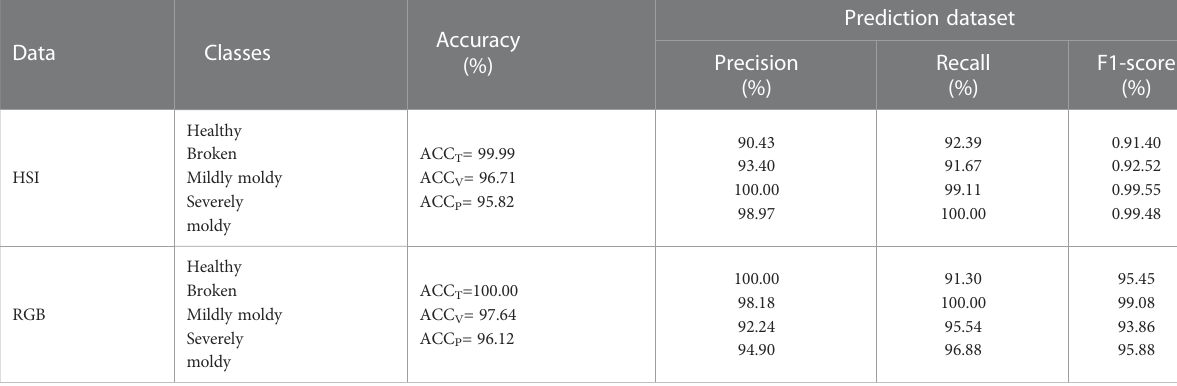
TABLE 6 Classi fi cation results of Shuf fl eNet_COCSP based on HSI and RGB images.